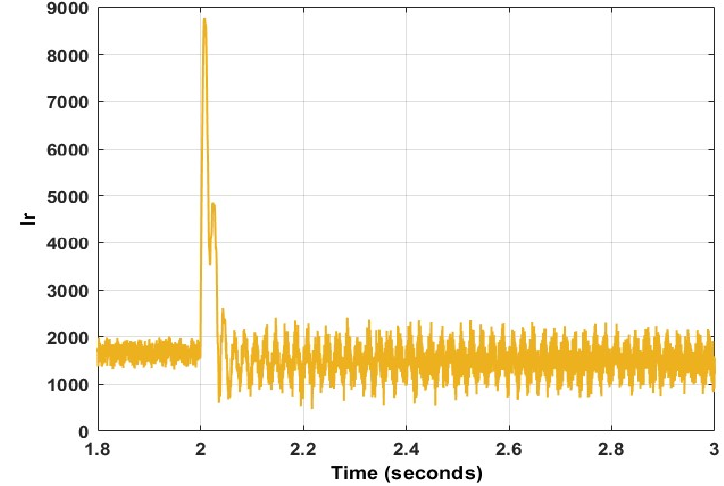
Figure 49. Rotor current transient using DCI at 90% dip.